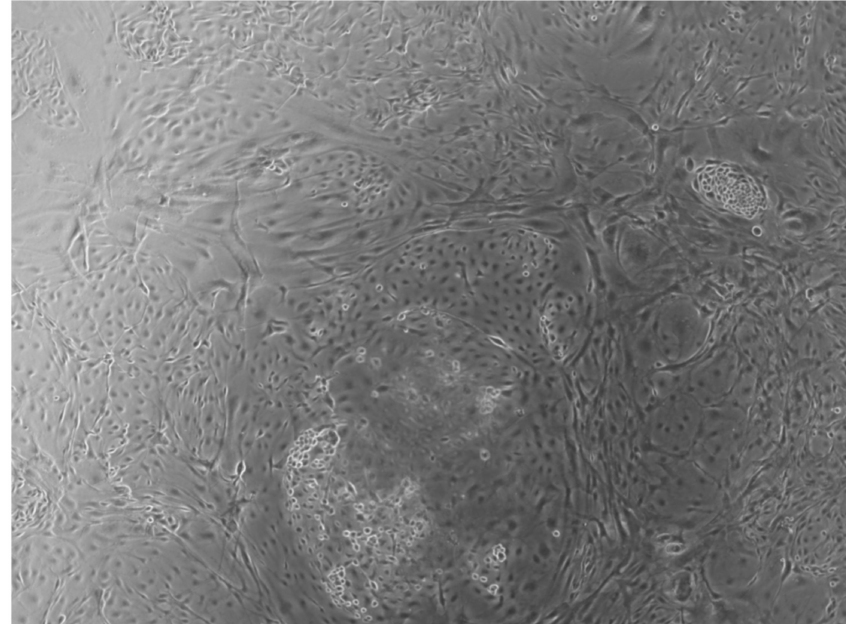
Figure 5. CTR8#14 P12 – RA showed the typical image of bone formation, where the collagen fibers, which make part of the extracellular matrix, begin to be arranged in a concentric way, thus giving a rudimentary appearance to the osteon, but one which is typical of the early stages of osteogenesis.